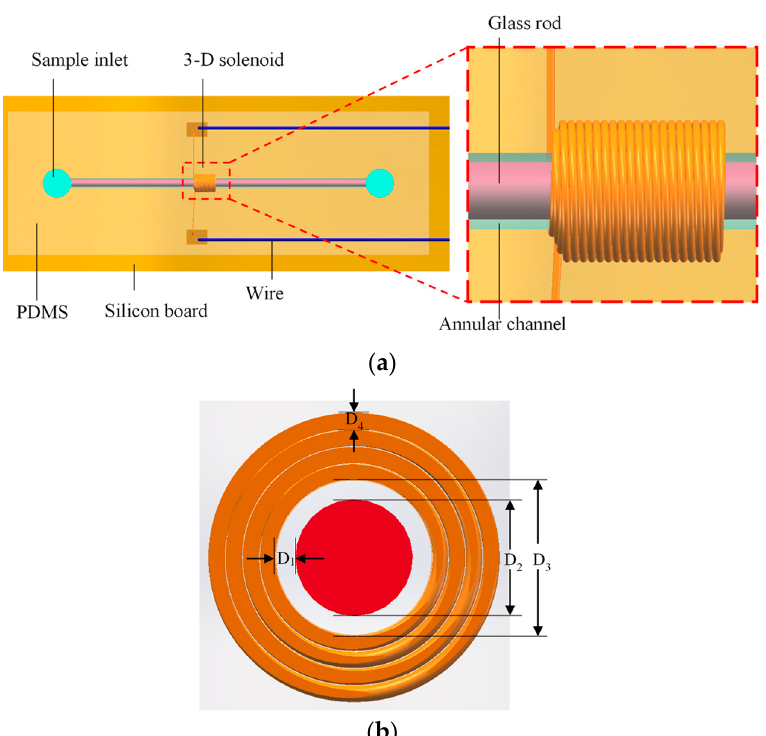
Figure 1. ( a ) The overall design of the sensor; ( b ) 3-D solenoid cross-section. The diameter of the annular channel D 1 = 300 μ m; the diameter of the glass rod D 2 = 1200 μ m; the overall diameter of